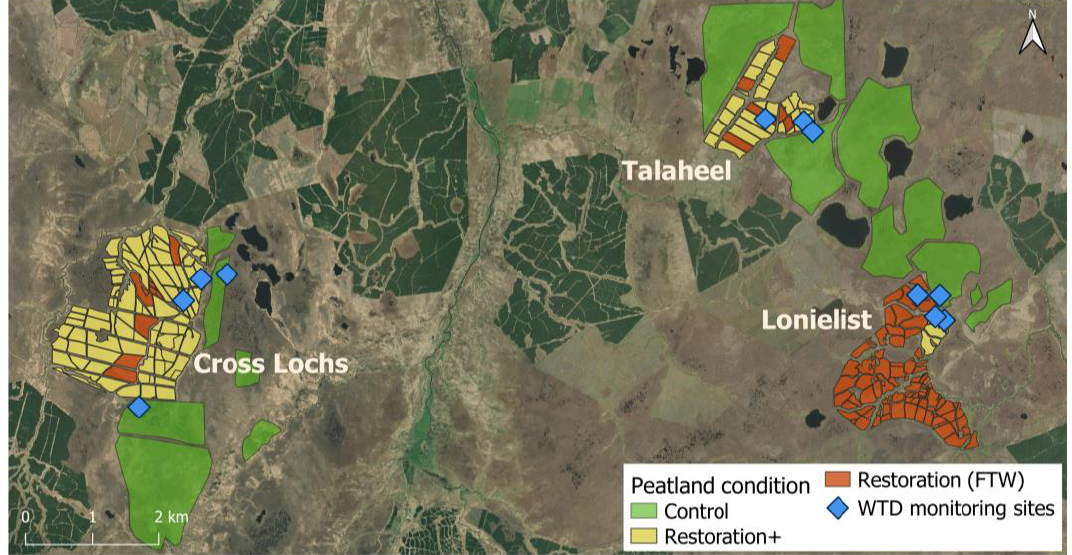
Figure 2. Forsinard Flows research site—different polygon colours represent the different management methods applied to peatland restoration. The eleven WTD monitoring points represent the chosen locations for analysis—4 near-natural Control sites, 3 Restoration (FTW), and 4 Restoration+ sites.